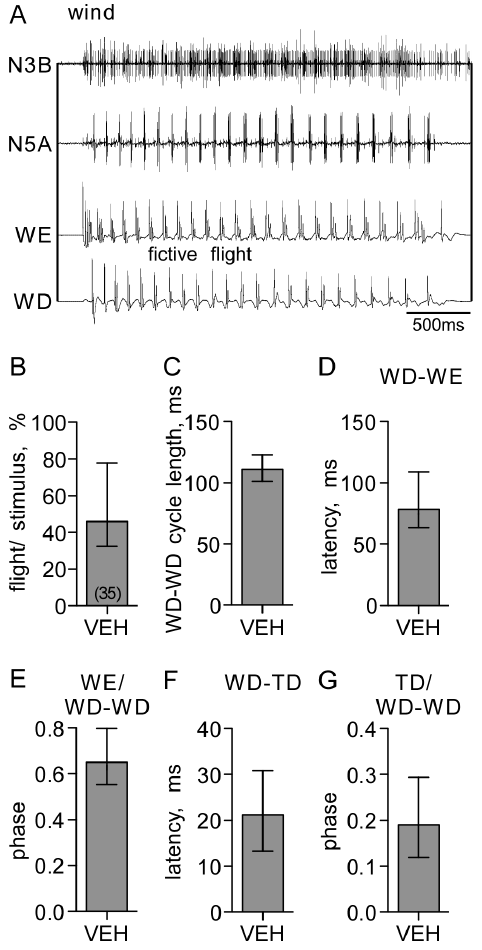
Figure 9. Evaluation of wind-evoked fictive flight. A Simulta- neous extracellular recordings of leg and wing motor units in a deafferented locust preparations with an intact head (abbreviations as in Fig. 1). B Bar giving the effectiveness of the wind stimulus as assessed from the percentage (%) of evoked flight sequences recorded for 35 animals, each in response to a series of 10 successive wind stimuli. C WD-WD cycle length. D WD-WE latency in ms. E phase of wing elevator in wing depressor cycle (WE/WD-WD). F WD-TD latency. G phase of leg unit in wing depressor cycle (TD/WD-WD). Columns in B–G give the median, and ticks the IQR.